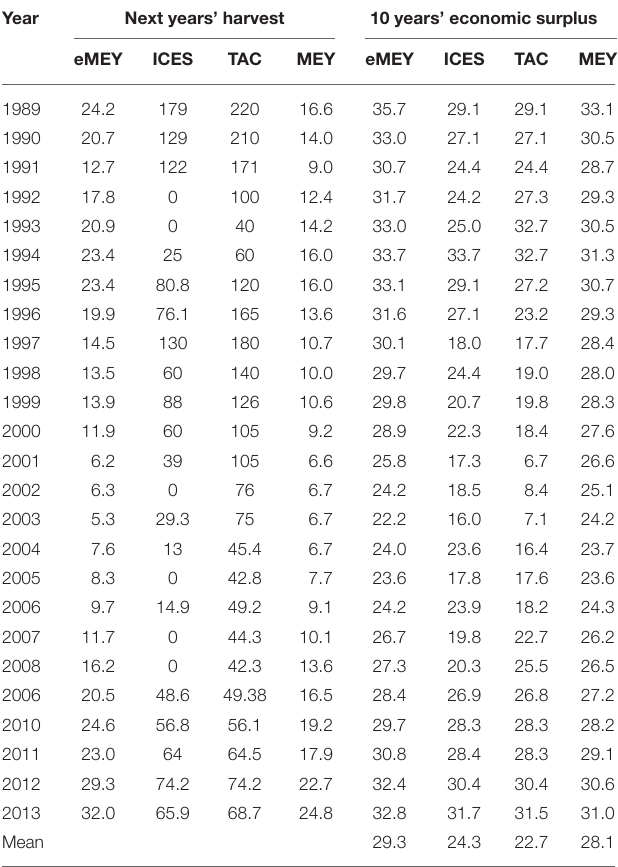
TABLE 1 | Summary of model output, comparing different management regimes considered: eMEY management, ICES scientific advice, politically agreed TACs, and classical